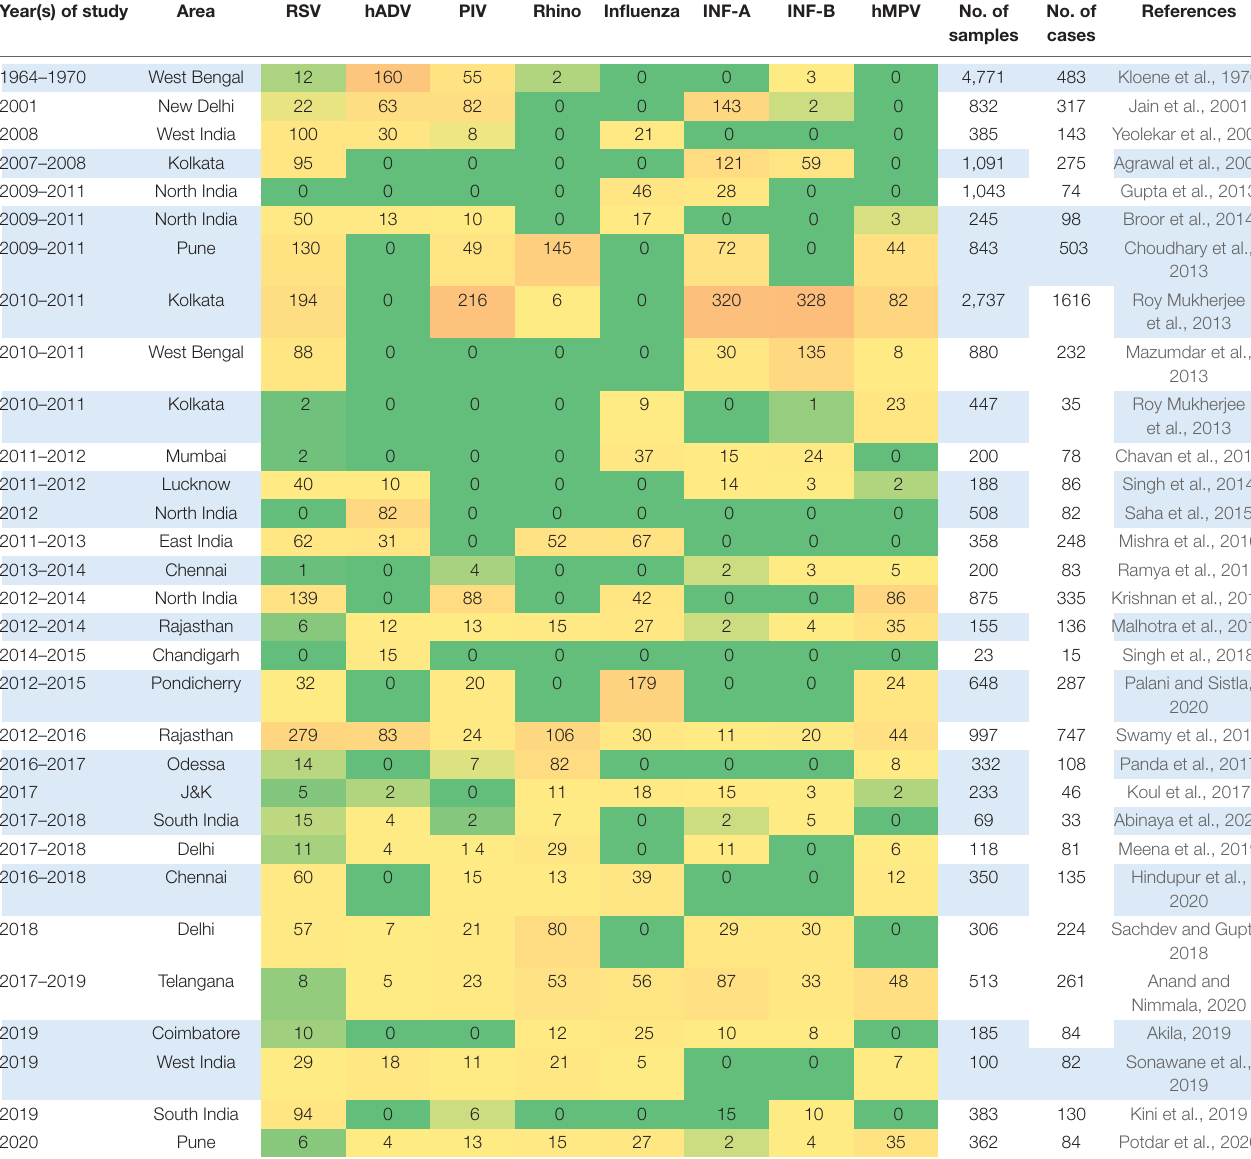
TABLE 1 | Summary of cases studied from various states/cities of